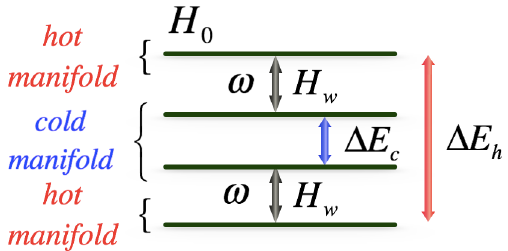
FIG. 4. Illustration of the engine used in the numerical simulation. By changing the time order of the coupling to H and to thermal baths, all three types of engines can be realized in the